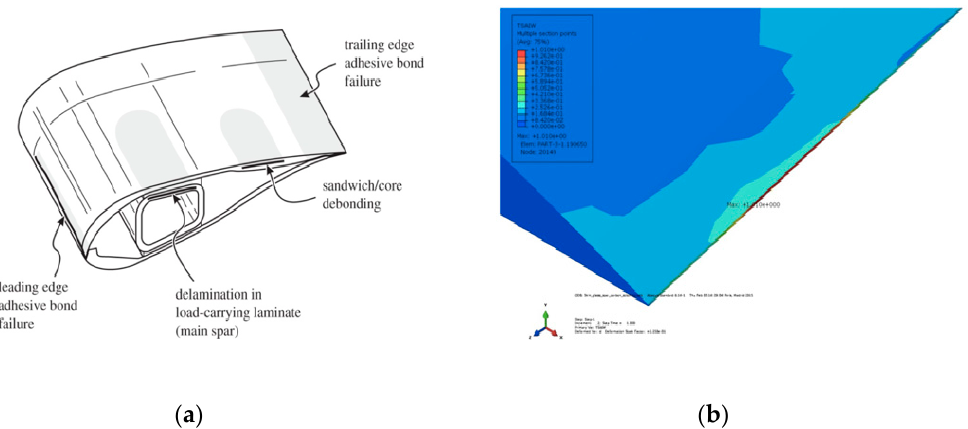
Figure 1. Wind turbine blades - ( a ) Adhesive bonding zones in blade - Critical zones of failure in blades, ( b ) Debonding zone observed at the trailing edge [1].